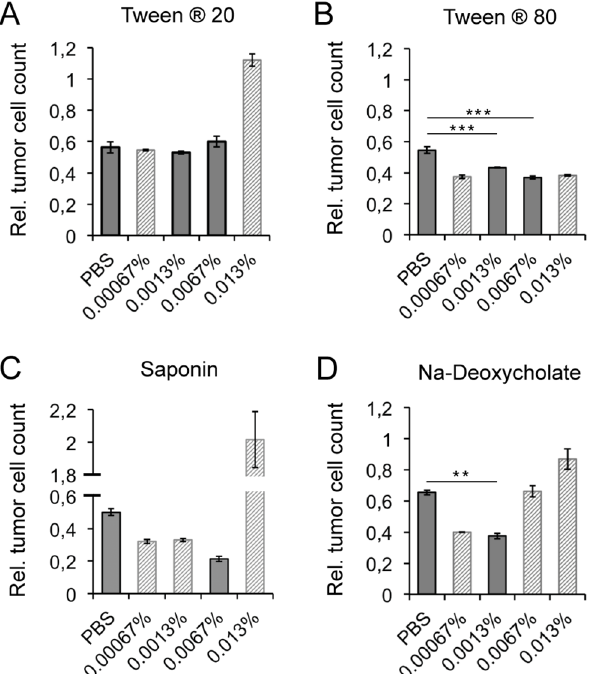
Fig 3. Impact of detergents on the r28M activity. The effects of the addition of the detergents Tween 1 20 (A), Tween 1 80 (B), saponin (C) and Na-deoxycholate (D) on the efficacy of PBMC to kill CSPG4 positive tumor cells (IPC-298) induced by 1000 ng/ml enriched r28M fraction are shown. Full grey bars: considered concentration of detergents (no positive or negative influence on the growth rate of CSPG4 positive cells and/ or PBMC — see S2 Fig). Dashed bars: concentration of detergents that influenced cell growth either positively or negatively (see S2 Fig); therefore data was not included in the given statistical analysis. Results show samples normalized to the controls. Cells incubated without r28M served as controls, their number was considered as 1. Values are means ± SE. Significance levels: x: p (cid:1) 0.05; xx: p (cid:1) 0.01; xxx: p (cid:1)